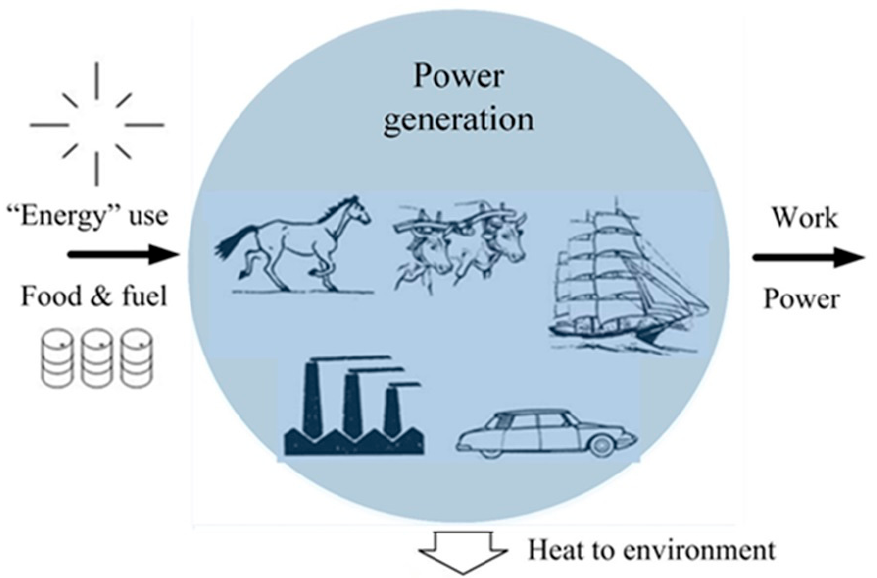
Figure 7. The evolution of the configuration of systems that convert the useful energy of fuels and foods into work and power.